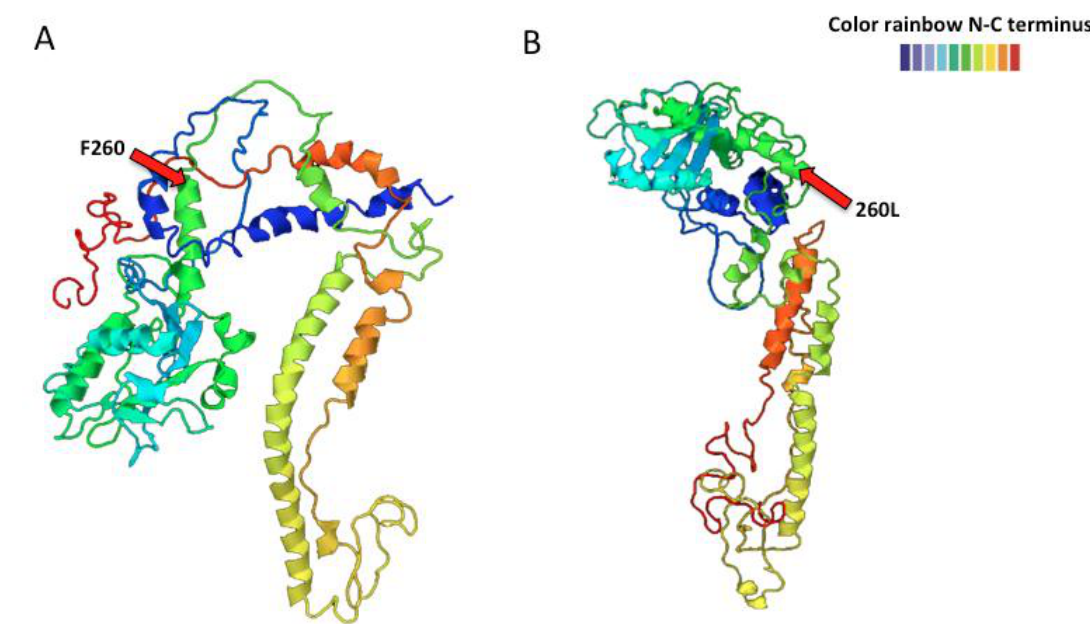
Figure 3. LCMV-ARM53b ( A ) and -Clone 13 GPC ( B ) predicted structure using the Phyre 2 program. One amino acid change from F to L at position 260 alters the predicted GPC structure. The structure goes from N-terminus in blue color to the C-terminus in red